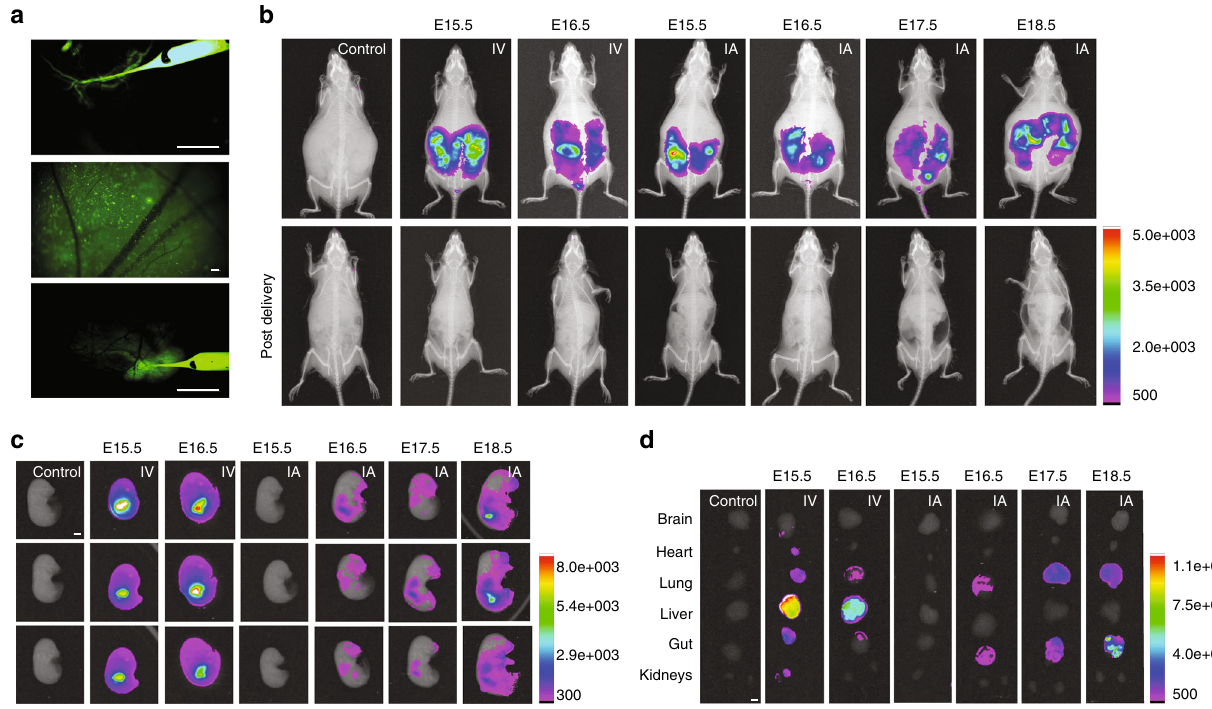
Fig. 1 Biodistribution of poly(lactic-co-glycolic acid) (PLGA) nanoparticles (NPs) after vitelline vein (IV) or intra-amniotic (IA) delivery. a Stereomicroscope image of a glass micropipette injecting NPs loaded with coumarin 6 (C6, green) into the vitelline vein at E15.5 (top), NPs in E15.5 fetal circulation 3 h after vitelline vein delivery (middle), and intra-amniotic injection of C6 NPs at E16.5 (bottom) ( n = 69 fetuses IV; n = 140 fetuses IA). Images are representative screen captures from full movies that are available in the supplementary materials (Supplementary Movies 1 – 3). Scale bars = 5 mm. b – d Distribution of DiD-loaded PLGA NPs 3 h after either IV or IA fetal injection in ( b ) time-dated pregnant B6 mice before delivery (top) and post surgical delivery of injected fetuses (bottom), ( c ) individual fetuses, and ( d ) fetal organs (control n = 9 fetuses, E15.5 IV n = 10 fetuses, E16.5 IV n = 7 fetuses, E15.5 IA n = 7 fetuses, E16.5 IA n = 8 fetuses, E17.5 IA n = 9 fetuses, E18.5 IA n = 10 fetuses). Scale bars = 2